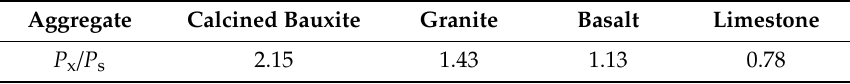
Table 9. P x / P s ratios for the di ff erent aggregates.